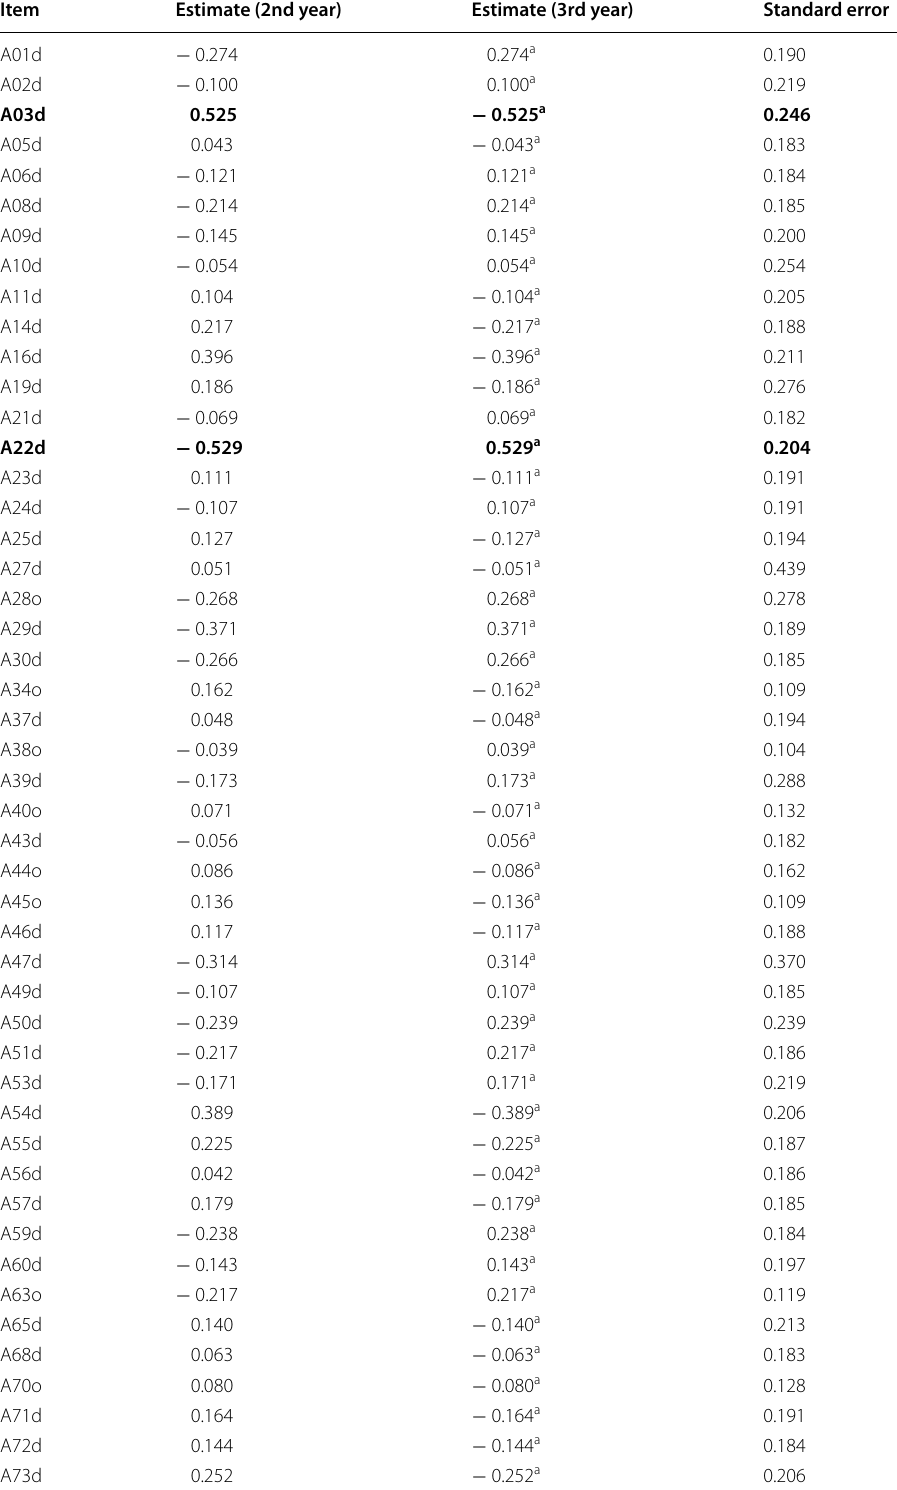
Table 9 DIF item analysis to identify subgroup invariance between years of nursing education at the item